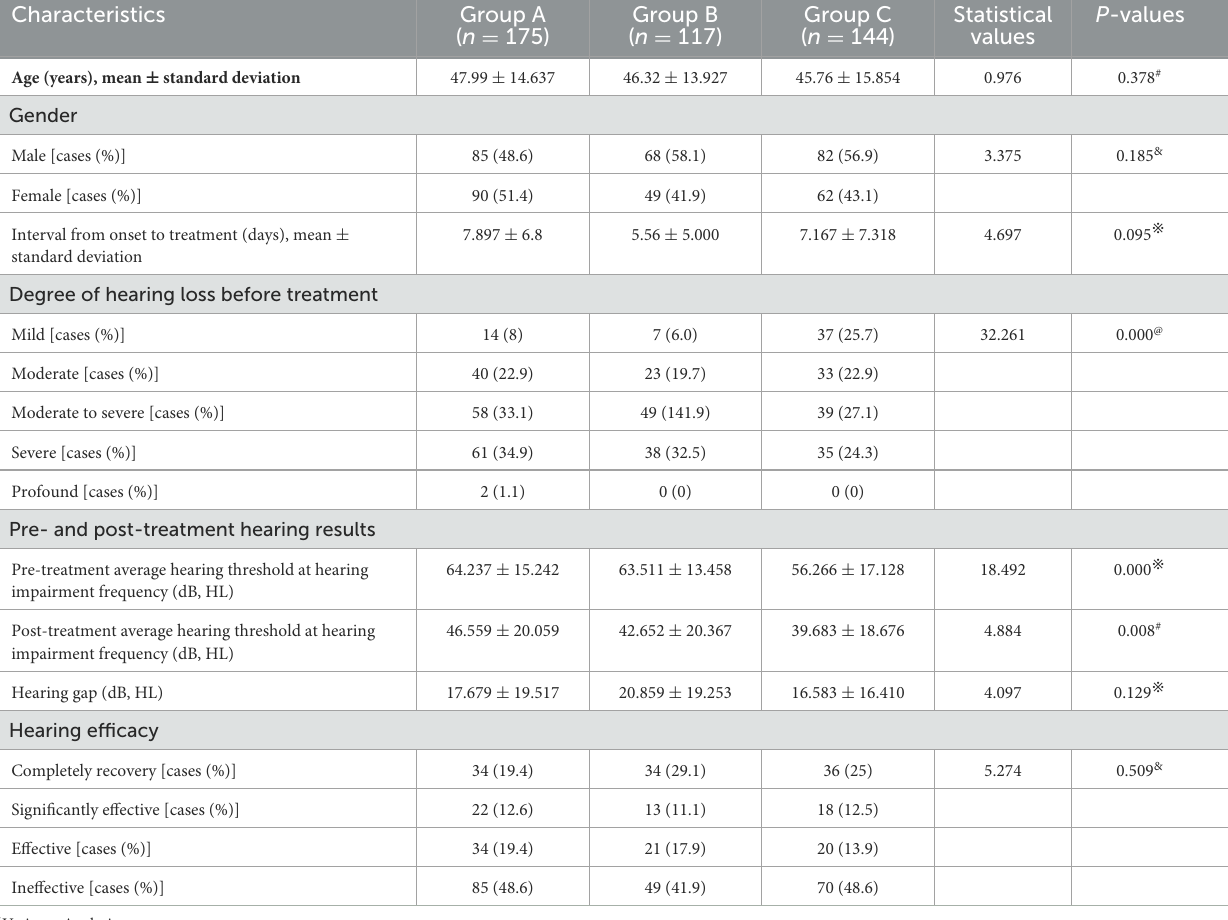
TABLE 6 Clinical characteristics and hearing efficacy of patients with flat-type SSNHL in the three groups. Characteristics